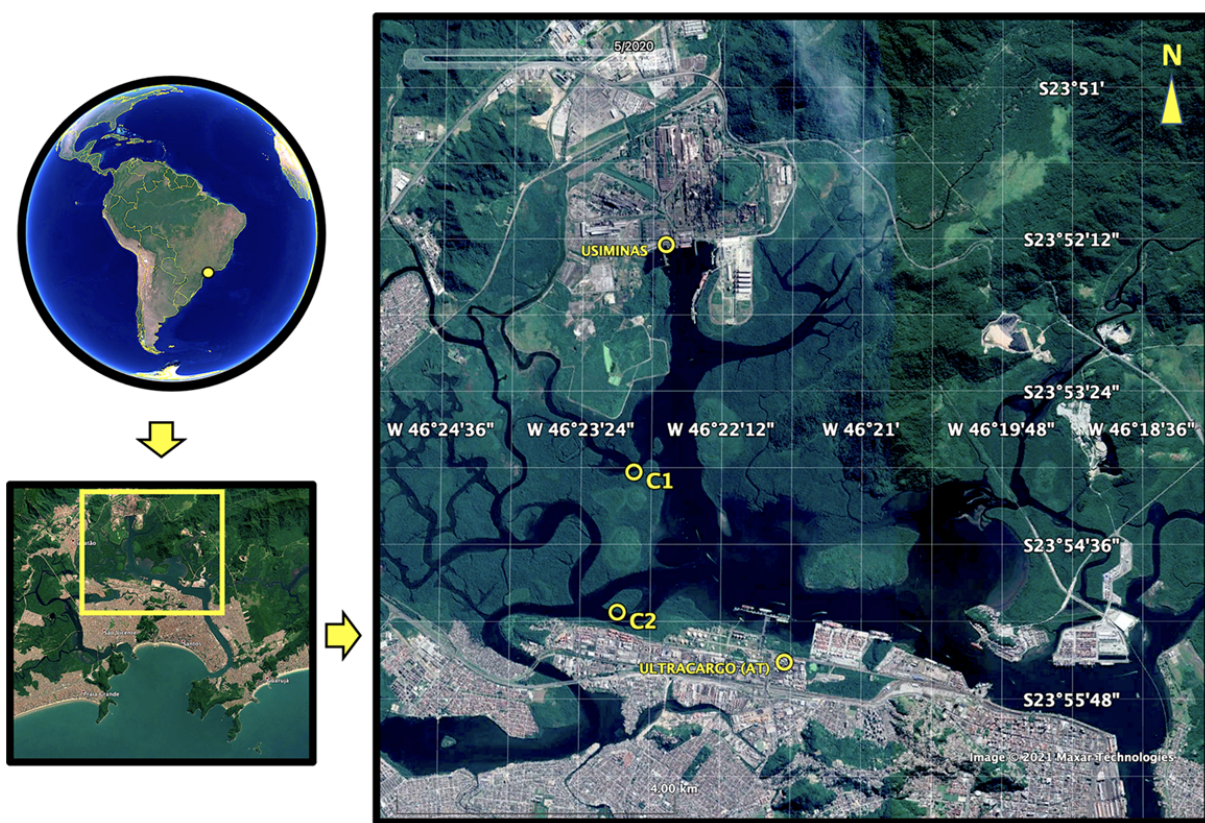
Figure 1. Inner region of the Santos-São Vicente Estuary, at Cubatão municipality, central coast of the State of São Paulo, Brazil, with two mangrove areas (C1 and C2), near to the environmental disaster which occurred at ULTRACARGO (AT). Source: modified from Google Earth® (Image © 2021 Maxar Technologies – Image from May, 24 th